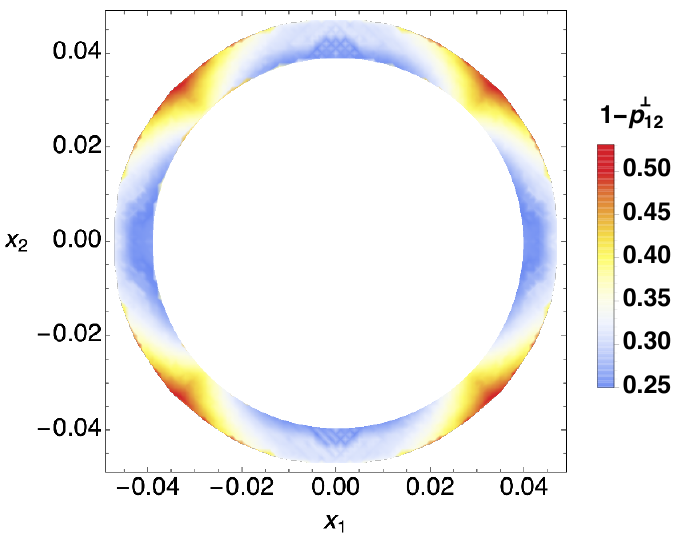
p ? ) with the model parameter x 1 and x 2 . Since lepton 12 (cid:0) p ? ), and clearly this never vanishes in this 12 (cid:0)